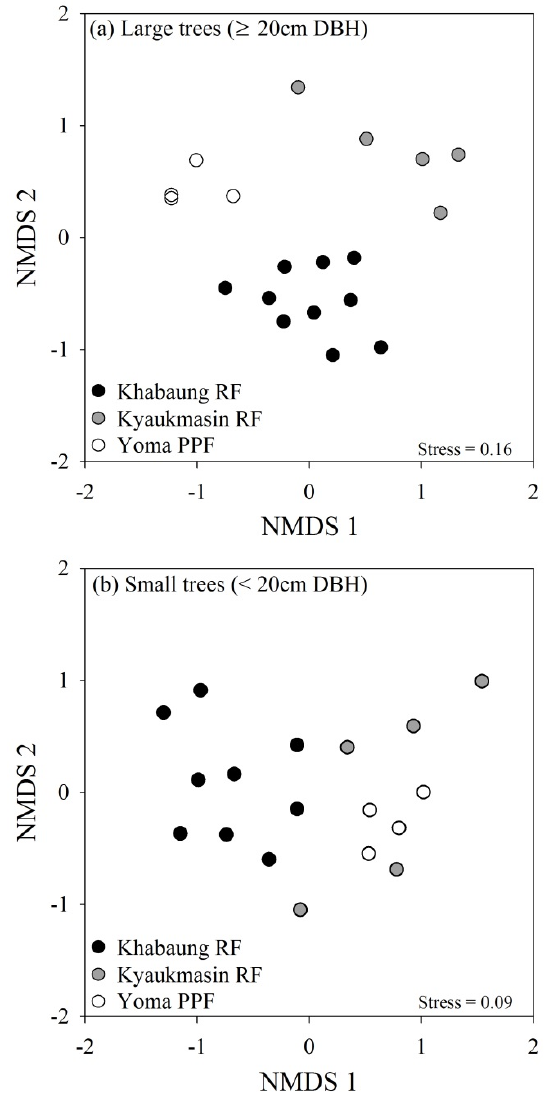
Figure 5. Non ‐ metric multidimensional scaling (NMDS) ordination of ( a ) large trees and ( b ) small trees at Khabaung Reserved Forest, Kyaukmasin Reserved Forest, and Yoma Protected Public Forest. In ( b ) one outlying plot from Khabaung has been removed to improve visual clarity (see methods for details).